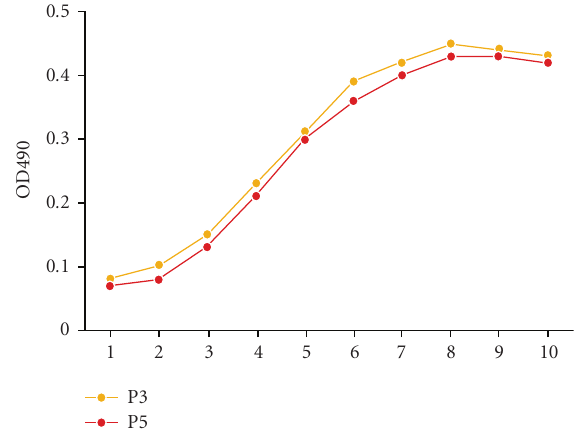
Figure 4: The growth curve of